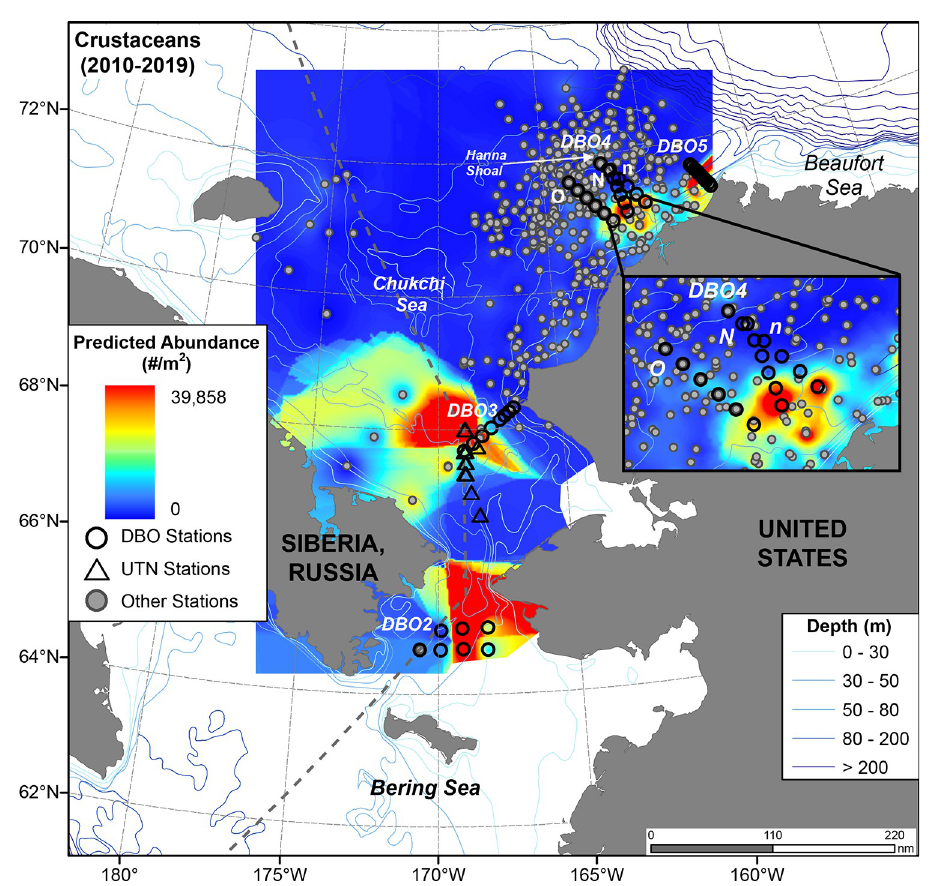
Fig 5. Distribution of infaunal crustacean abundance (#/m 2 ) at all stations where macrofauna were sampled during the period 2010–2019 in the northern Bering and eastern Chukchi seas. Key: open circles = DBO stations, open triangles = UTN stations, and closed gray circles = all remaining stations. Note that DBO4 has 3 transect links: O = original line 1, n = new line 1, and N = new line 2. The spatial interpolation map was made using the Geostatistical Analyst Wizard Inverse Distance Weighting (IDW) tool in ESRI’s ArcGIS Desktop v.10.8.1 (ESRI 2020) with default settings. See S3 Table for DBO sampling site information and crustacean abundance data. The remainder of the all station crustacean abundance data are available at Arctic Data Center DBO data portal < https://arcticdata.io/catalog/ portals/DBO/Data > .